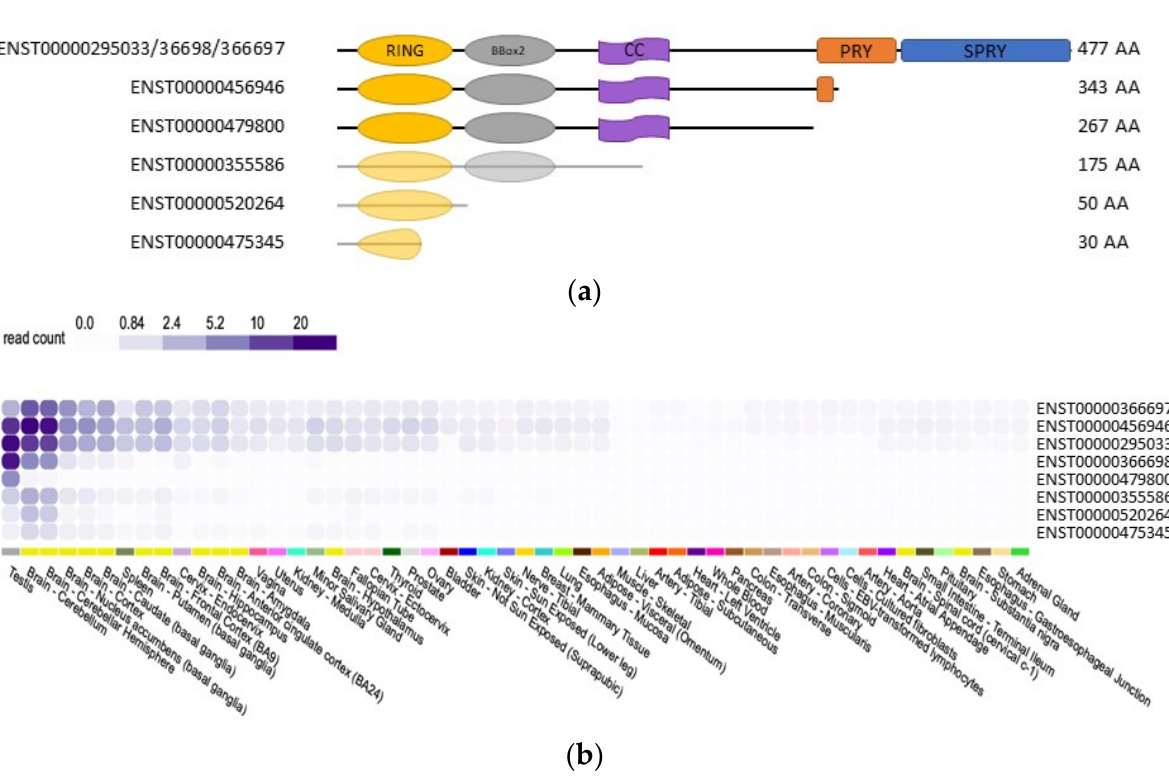
Figure 5. ( a ) Schematic representation of the expected domain architecture of TRIM17 isoforms and the corresponding protein coding lengths (in amino acids) (from ensembl.org, 21 February 2021); ( b ) expression profile of TRIM17 isoforms [Source:HGNC Symbol;Acc:HGNC:13430].